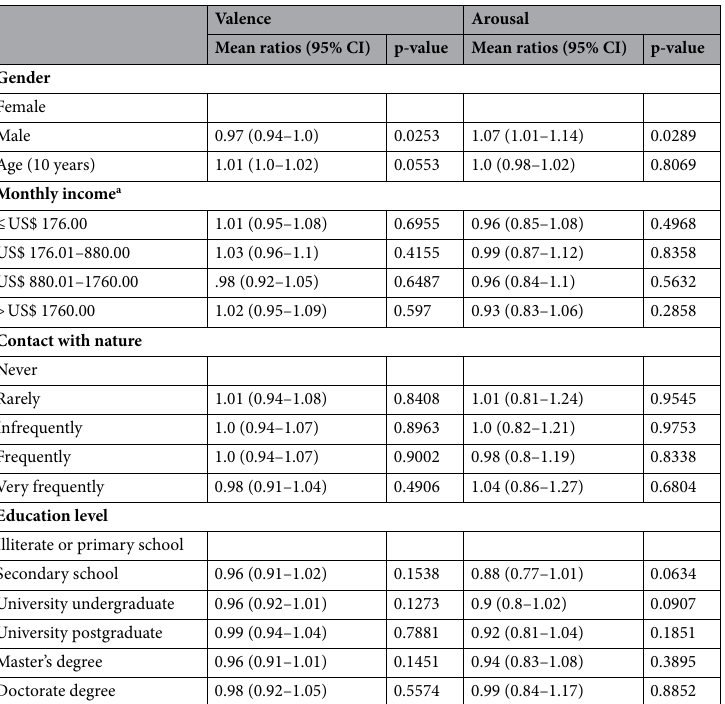
Table 5. Association of valence and arousal ratings with participant characteristics (n = 24,654). a Approximate conversion from Brazilian Real to American Dollar on May 20, 2020.